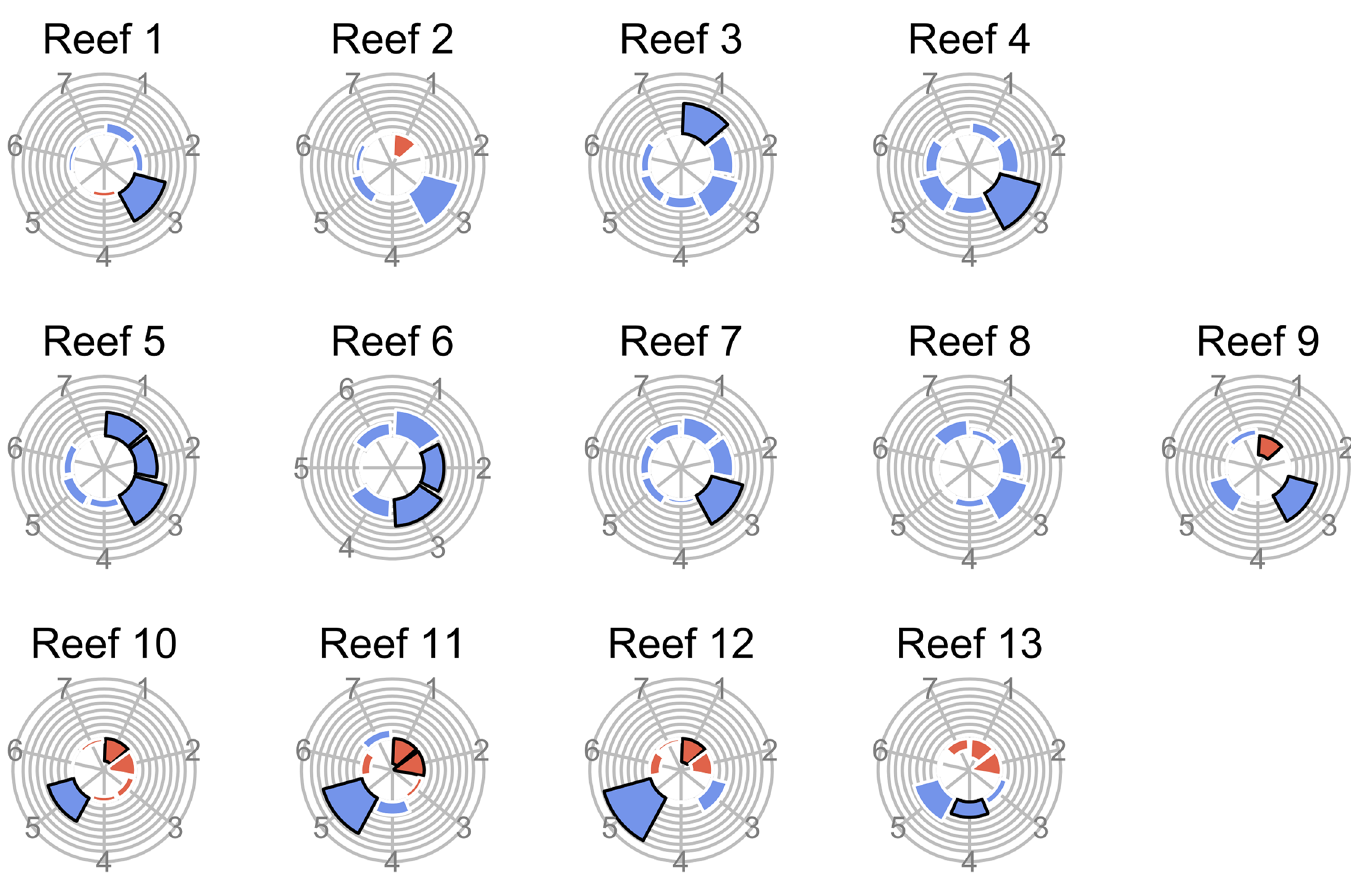
Fig 5. Species contributions to the temporal shift in fish composition for each reef. Only the seven species that contributed the most to this temporal trend are pictured. These species are ordered according to their relative frequencies in the whole data set 1: Ctenochaetus striatus (a scraper, Acanthuridae); 2: Chlorurus sordidus and 3: Scarus psittacus (two scrapers, Scaridae); 4: Naso lituratus (a browser, Acanthuridae); 5: Acanthurus olivaceus (a grazer, Acanthuridae); 6: Scarus oviceps (a scraper, Scaridae) and 7: Odonus niger (a plankton feeder, Balistidae). Polygon lengths are proportional to the species contributions to the temporal shift. Positive contributions (in blue) indicate species whose biomasses increased through time, while negative contributions (red) indicate species whose biomasses decreases through time. Polygons of species that are also indicators are surrounded with a black frame (see also S4